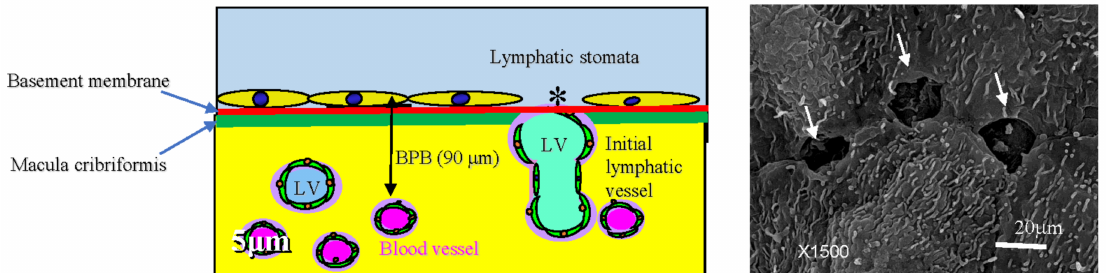
Figure 1. Normal fundamental structure of the peritoneum. Mesothelial cells cover the basement membrane (BM, brown line), and collagen plate named the macula cribriformis (MC, green line) lies just below the basement membrane. Lymphatic vessels (LV) permeate the shallow subperitoneal space (left). The blood–peritoneal barrier (BPB) consists of mesothelial cells, BM, MC, and connective tissues between the MC and submesothelial blood vessels. Some submesothelial lymphatic vessels are attached to small holes in the MC and mesothelial cell layer ( left ), *, which are named lymphatic stomata ( right ). Scanning electron microscopic study was performed by Miura M, one of the authors of the article, and the techniques of SEM are described in reference [16].